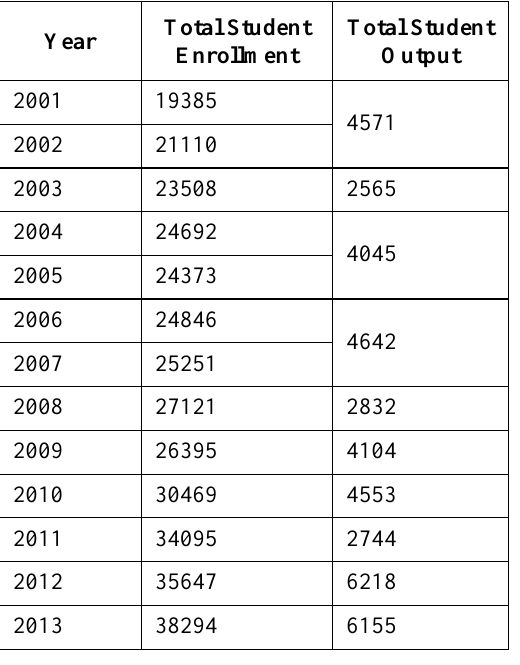
Table 02: Total Student Enrollment and Output from Year